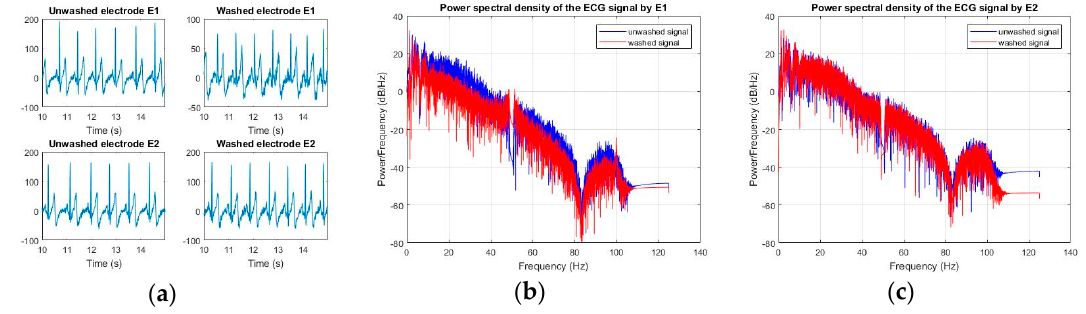
Figure 12. ECG analysis (express wash), ( a ) ECG signals for E1 and E2 ( b ) power spectrum density E1 ( c ) power spectrum density E2.